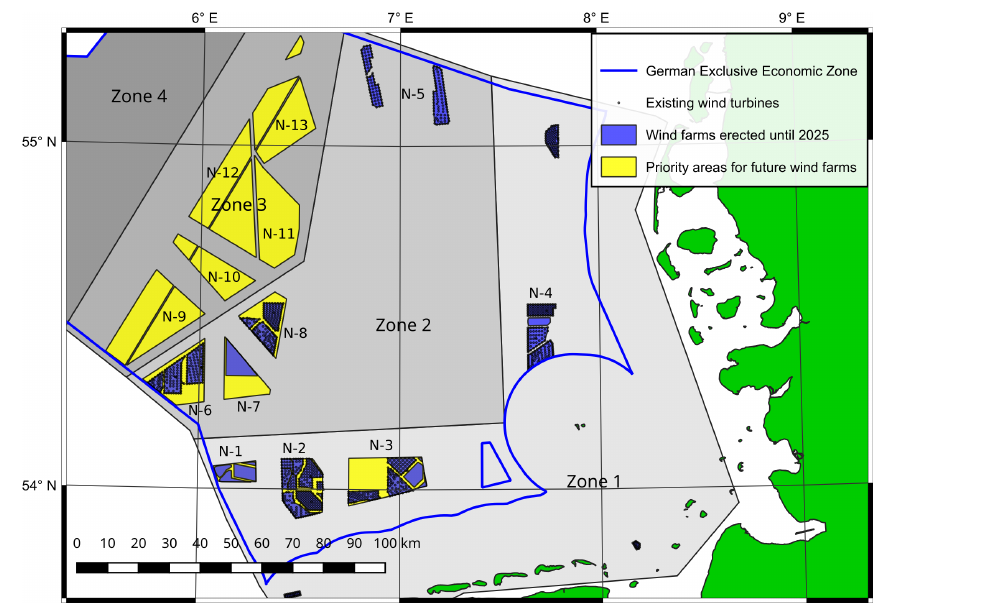
Figure 1. Existing wind farms and priority areas for future wind farms in the German Exclusive Economic Zone in the German Bight. The map is based on data that are publicly available at https://www.geoseaportal.de (last access: 4 March